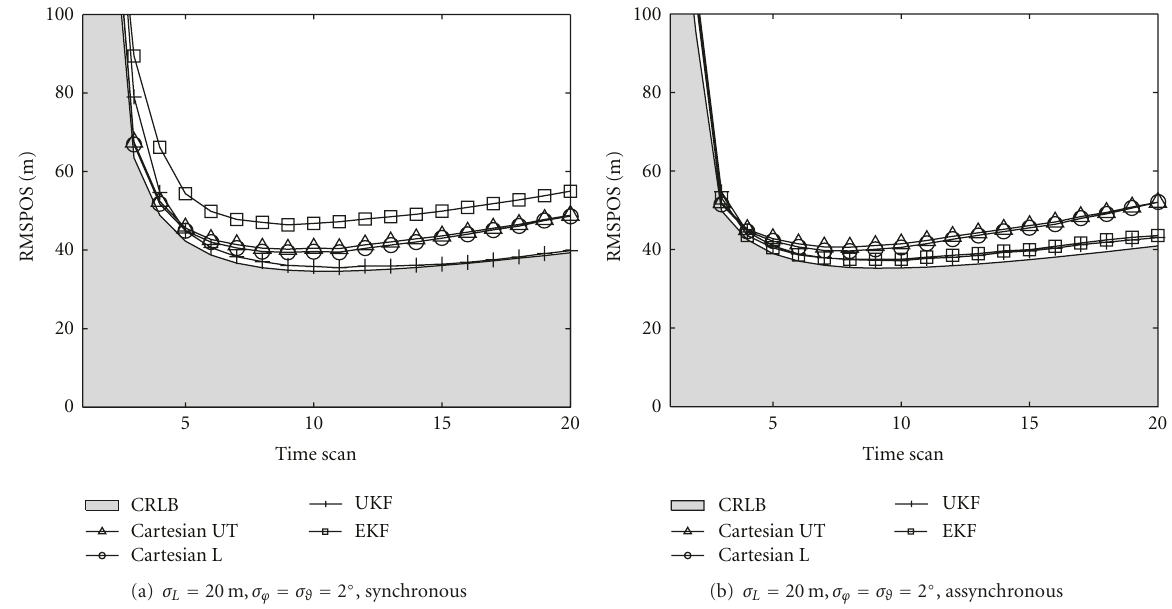
Figure 20: Comparison of di ff erent types of Kalman filters: multistatic scenario with two sources and one